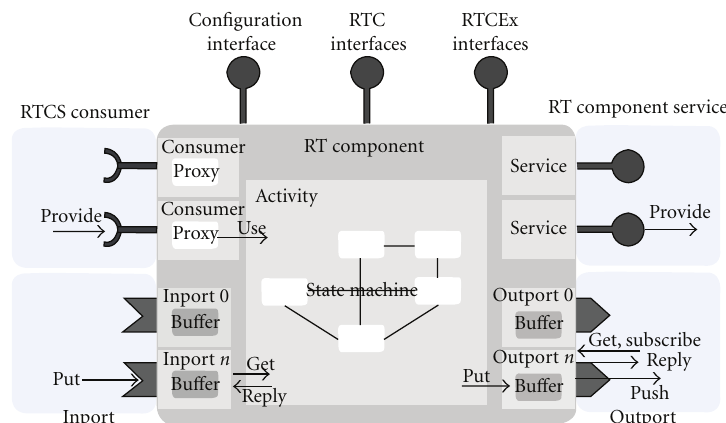
Figure 7: RT-Component Architecture (© (2006) IEEE) (reproduced from [28] with permission of Dr. Noriaki Ando).